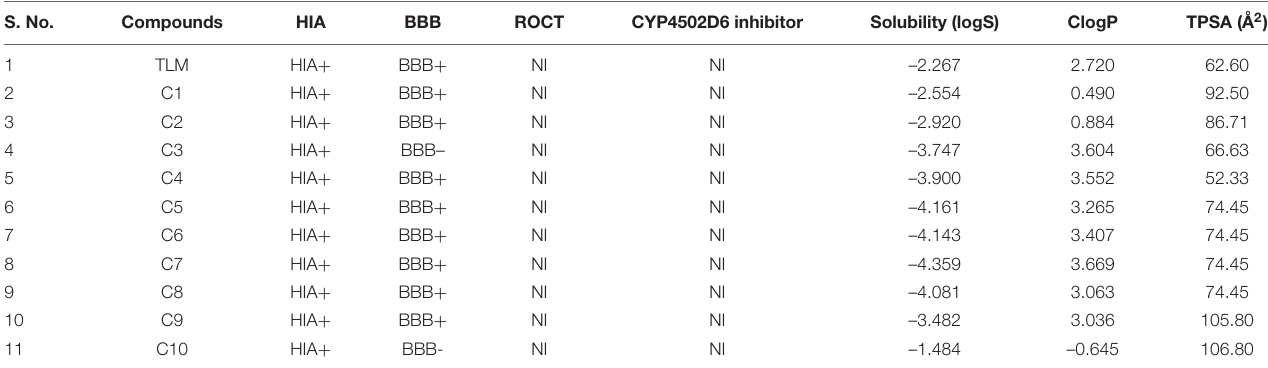
TABLE 2 | ADME analysis of mtFabH inhibitor and lead molecules. S.